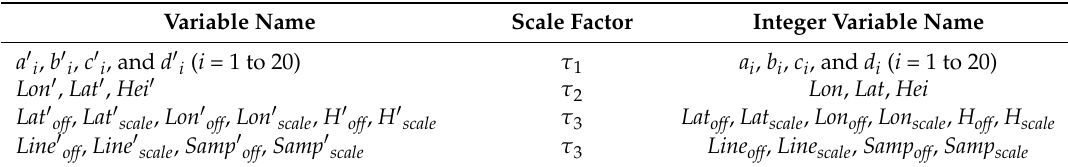
Table 1. Scale factors and integer